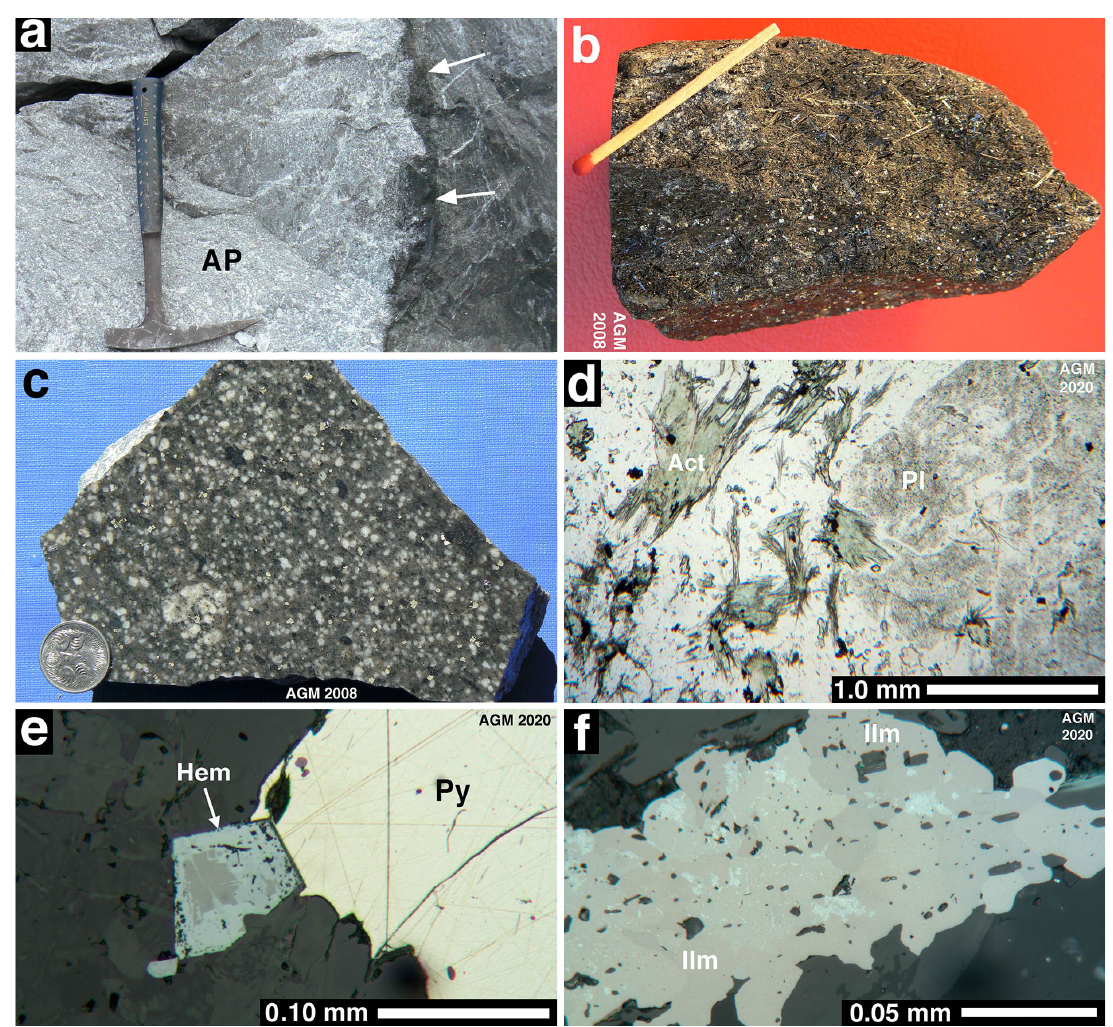
Figure 8. Photographs and photomicrographs of the Albite-Actinolite Porphyry: pit floor at 224 m above sea level, samples HB-8a and HB-9. ( a ) Altered Porphyry (AP), the post-kinematic contact selvage of black actinolite (arrows) overprints dolomite-veined talc–chlorite-phlogopite schist. The hammer is 32 cm tall. ( b ) Felted actinolite needles and cube-shaped pyrite in the contact selvage of the porphyry. The matchstick is 43 mm long. ( c ) Porphyry: white plagioclase pheno- and glomerocrysts and a rounded plagioclase aggregate in an albite-rich groundmass containing actinolite (15–20 vol.%), calcite (5%), pyrite (3–5%), and hematite (0.2%). The coin is 19 mm across. ( d ) Porphyry: plagioclase glomerocryst (Pl) partly replaced by actinolite (Act) and albite. Plane polarized light. ( e ) Porphyry: hematite (Hem) rims magnetite (brown core) in contact with pyrite (Py). Plane polarized light reflected in air. ( f ) Porphyry: aggregate of ilmenite (Ilm) with blue hematite domains of higher reflectance. Plane polarized light reflected in air.